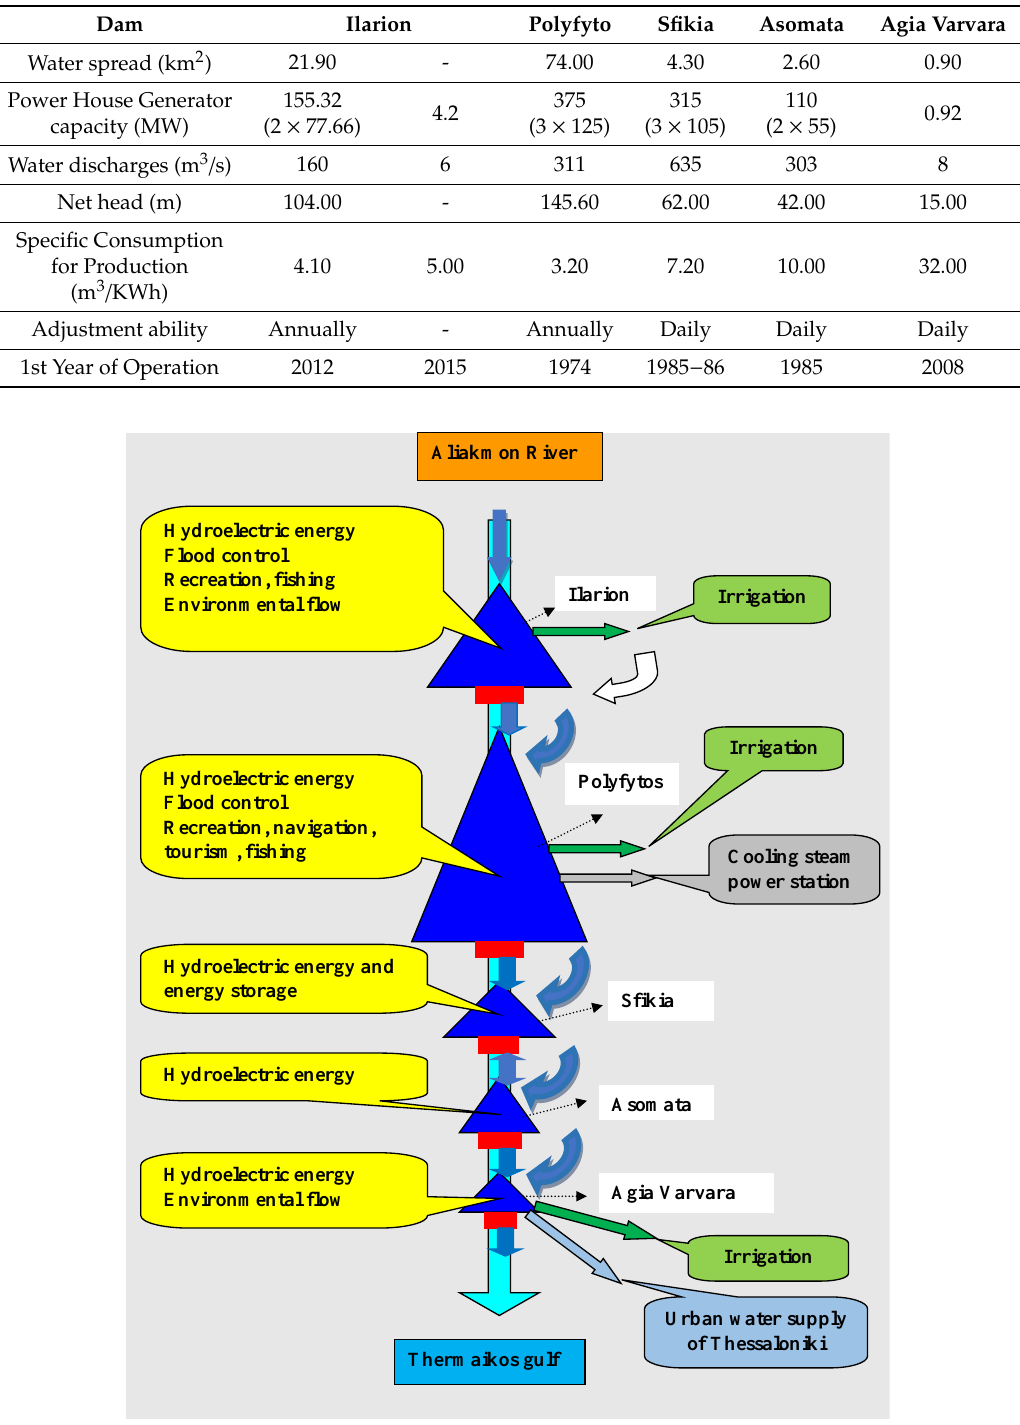
Figure 2. Schematic view of the Aliakmon River basin, resources and demands. Table 2. Technical characteristics of reservoirs and hydropower stations of the Aliakmon River [11].